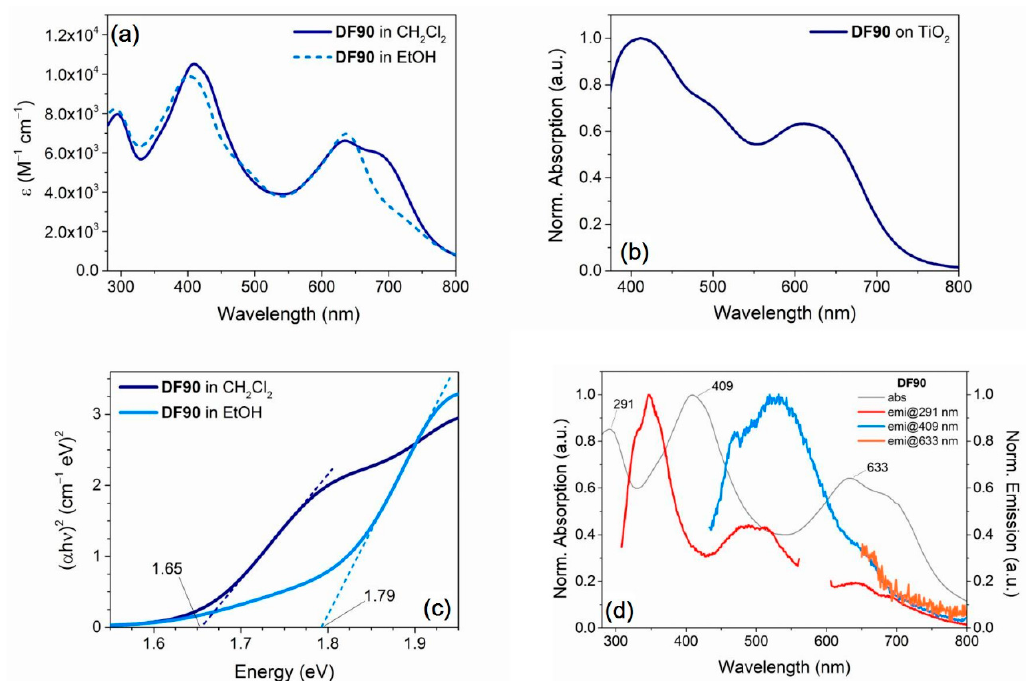
Figure 8. UV − vis absorption spectra of dye DF90 in CH 2 Cl 2 and EtOH solution ( a ), and adsorbed on TiO 2 ( b ); Tauc plots corresponding to the absorption spectra in solution ( c ); fluorescence emission spectra in CH 2 Cl 2 solution after excitation at different wavelengths ( d ); in the latter scheme, a peak at 582 nm deriving from second-order diffraction of incident light was deleted for clarity (red trace).